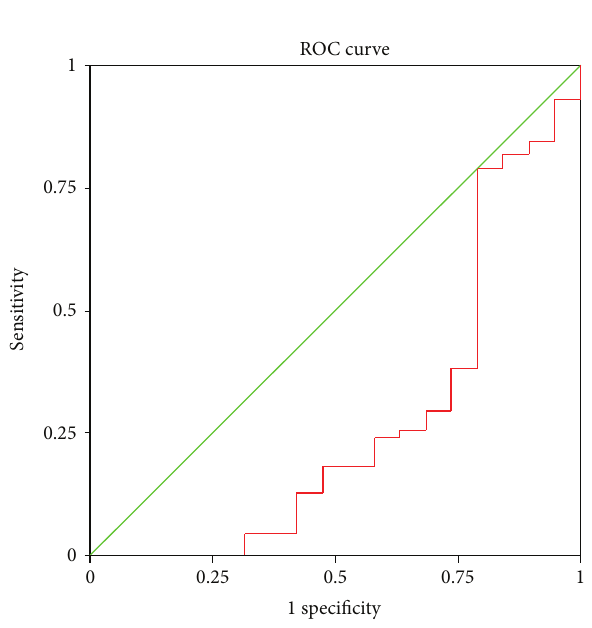
Figure 1: ROC of SF-36 scores prior to